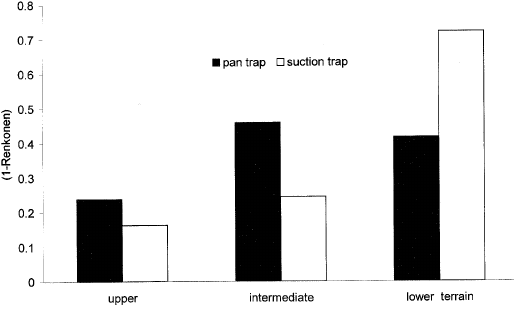
Fig. 6. Rate of changes in community structure (1-Renkonen in- dex of similarity) after mowing in 1997.